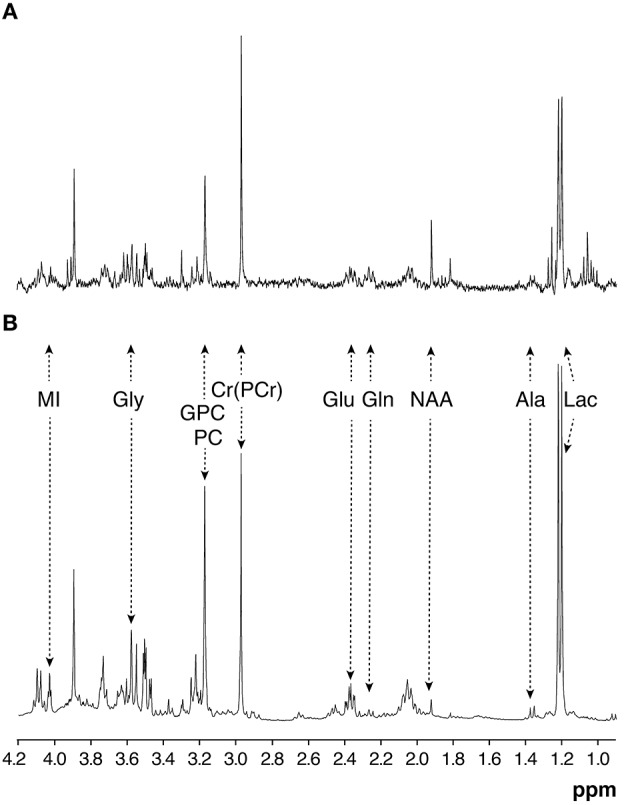
Representative HR-1H MRS (360.13 MHz, 22°C, pH 7.2) from extracts of two glioma grade II biopsies with very different OS outcomes. (A) 149 w. (B) 600 w. MI, myo-inositol; Gly, glycine; GPC, glycerolphosphorylcholine; PC, phosphorylcholine; Cr, creatine; PCr, phosphocreatine; Glu, glutamate; Gln, glutamie; NAA, N-acetyl-aspartic acid; Ala, alanine; Lac, lactate.